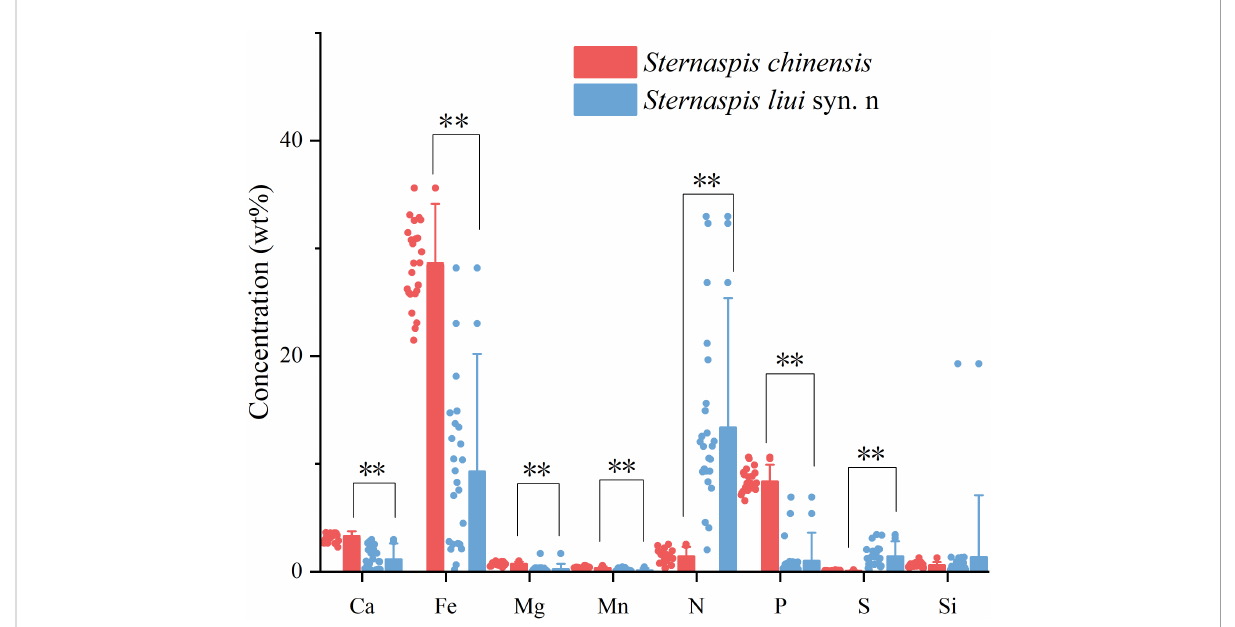
FIGURE 3 Comparison of the main element contents in the ventro-caudal shields of the two sternaspid morphotypes. Bars: mean ± SD (n = 24). Double asterisk (**) above the bars represents a signi fi cant difference between the two synonymous species ( p < 0.01, Student ’ s